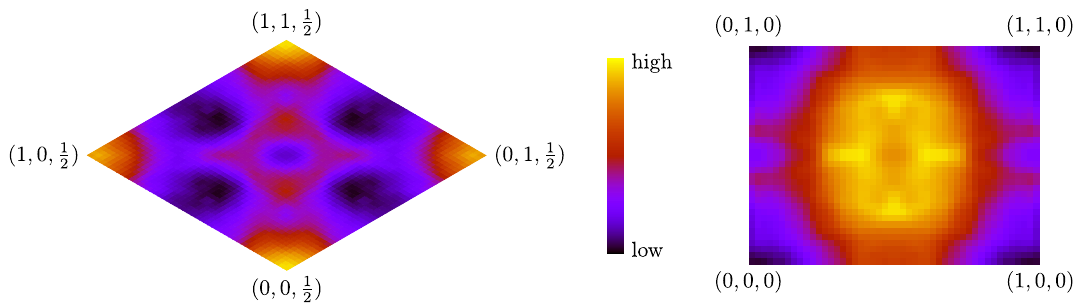
Figure 3: Calculated Lindhard susceptibility of LaNiO (right)